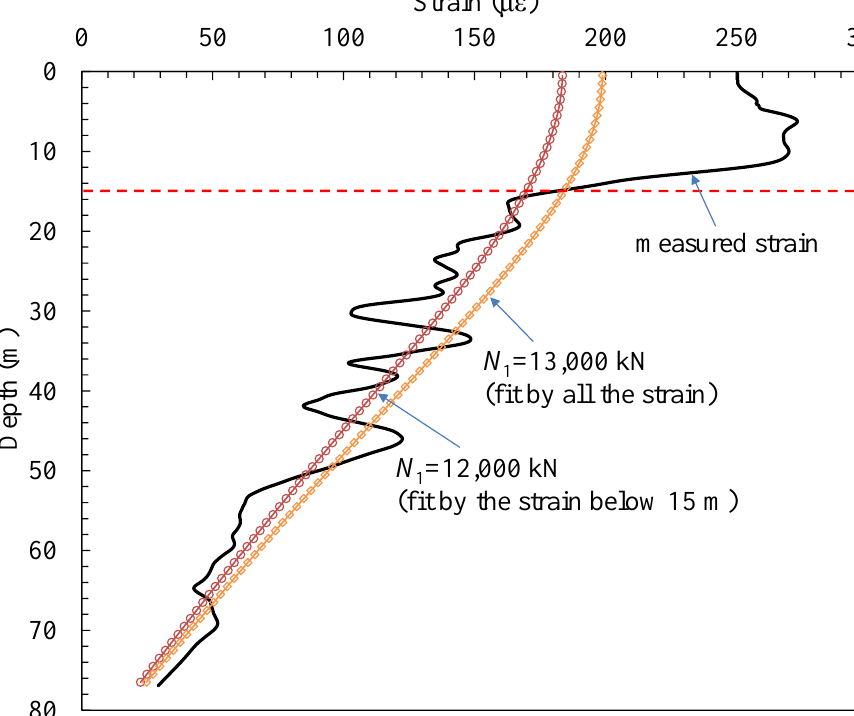
Figure 12. Effect of the data in the shallow section on the fitted axial